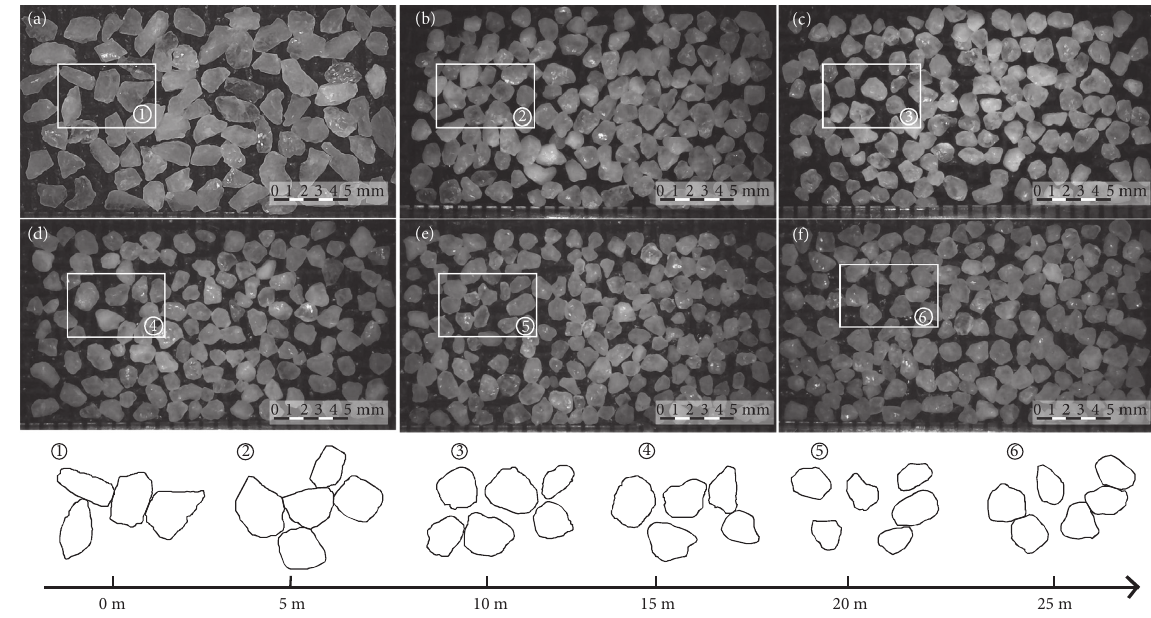
Figure 8: Morphometric changes in coarse particles (1-1.5mm) under shear under optical microscopy.